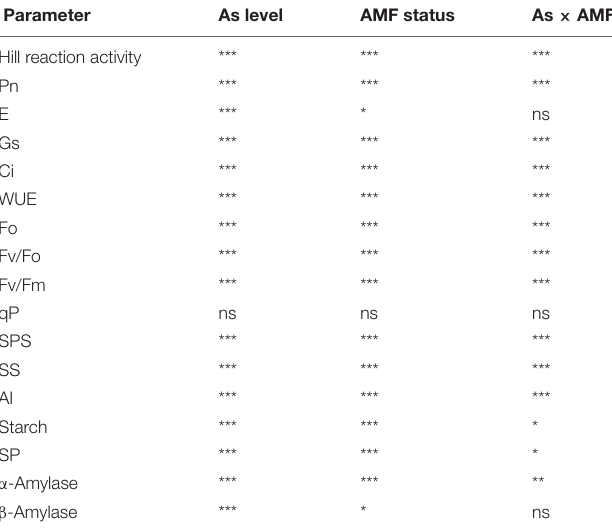
TABLE 3 | Two-way analysis of variance showing the effect of As level, mycorrhizal status, and their interaction on various physiological attributes of Triticum aestivum